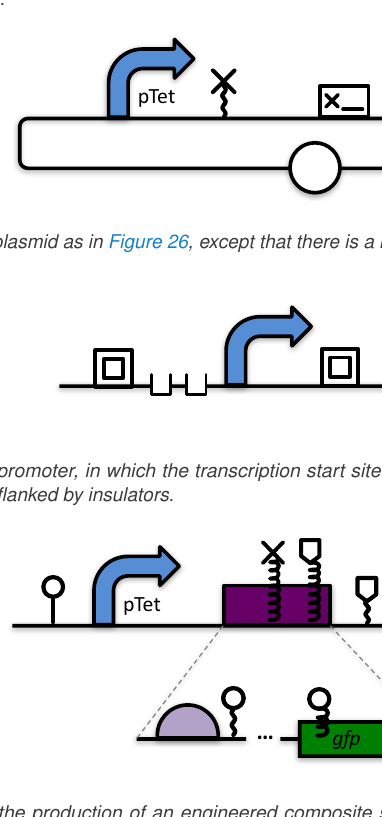
Figure 31: Promoter regulating the production of an engineered composite sequence that includes RNA and protein stability elements at its 3’ end, as well as an internal site for protease cleavage, as well as the expansion of the composite to show it contains a ribosome entry site. coding sequence, and other omitted details. Single residue locations of interest are indicated for the DNA (before the promoter), RNA (after the ribosome entry site), and protein (in the CDS).